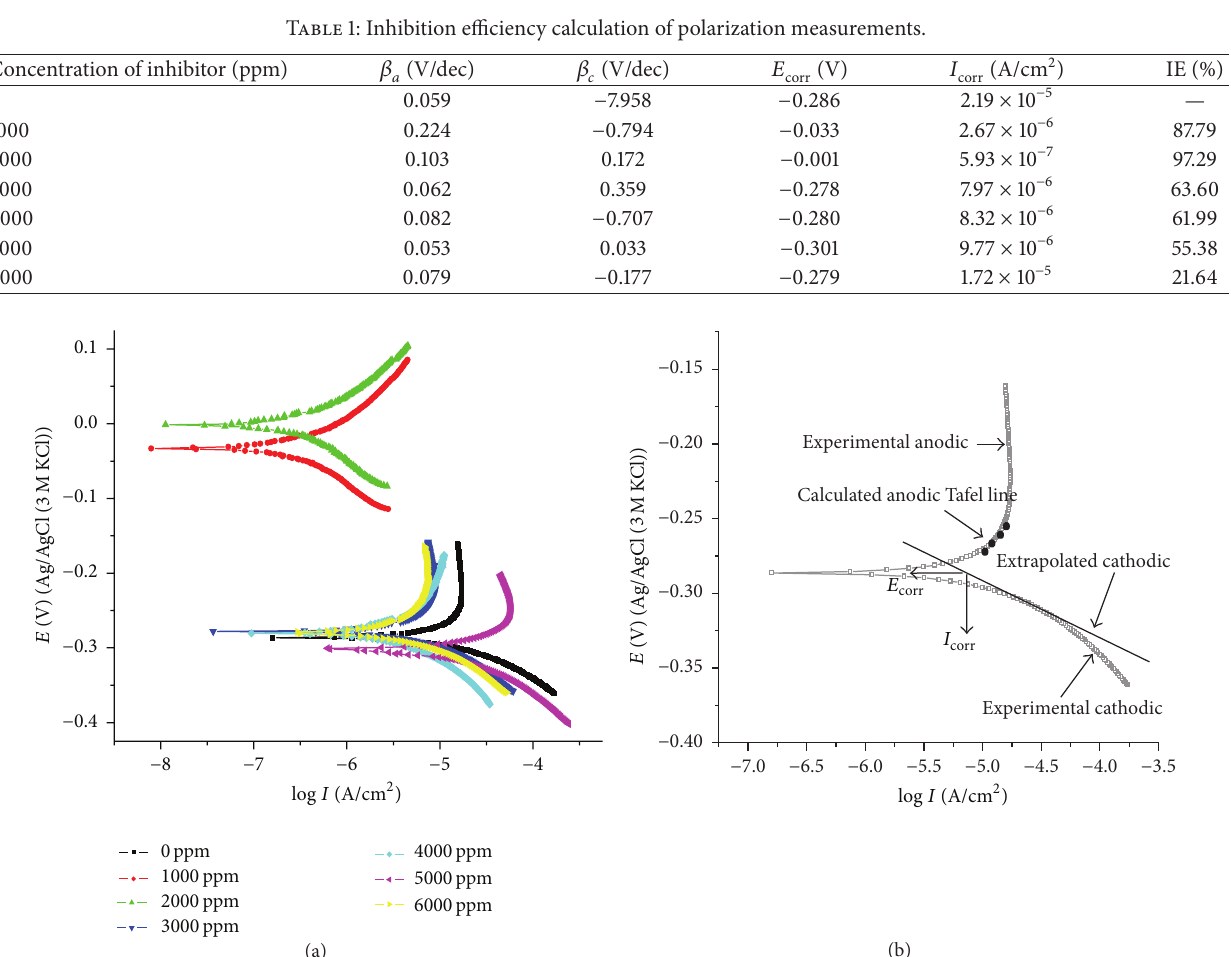
Figure 1: (a) Tafel plots with various concentrations of inhibitor and (b) extrapolarization of Tafel plot for 304SS in 0.5 MH 2 SO 4 solution.